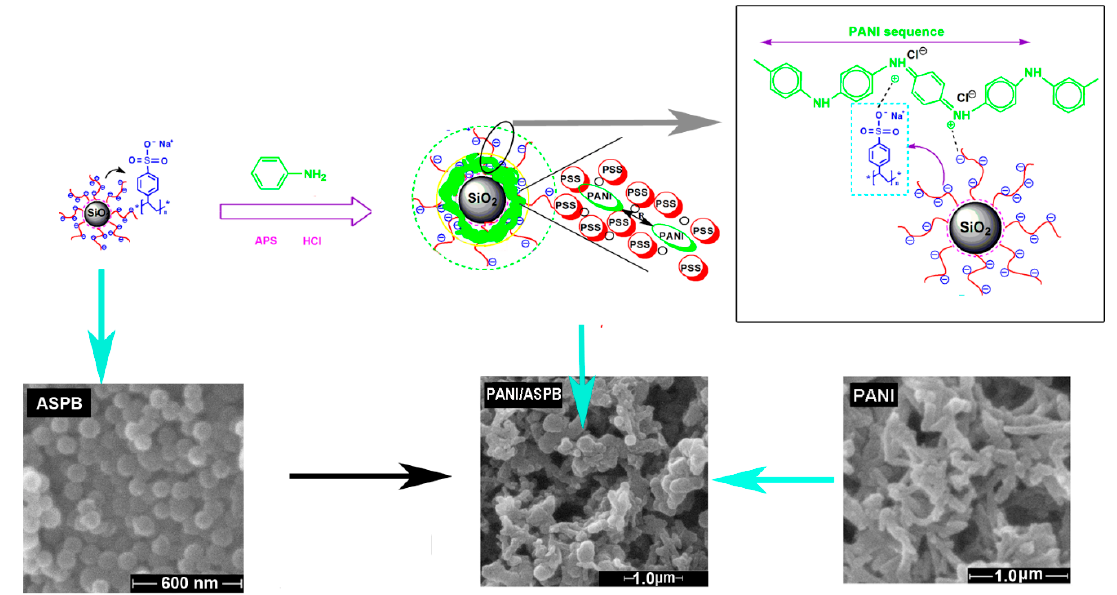
Figure 12. Schematic representations of reaction process and doping mechanism of